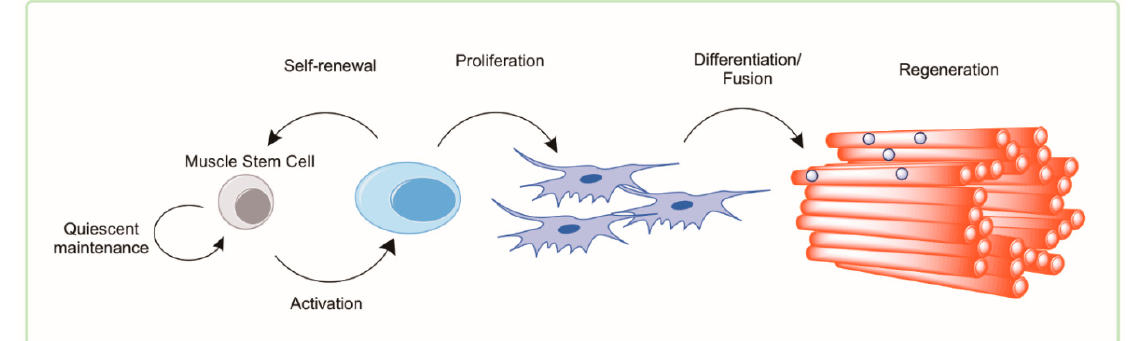
Figure 2. Activation of the Muscle Stem Cell. Adult, resident skeletal muscle stem cells—termed satellite cells—were originally identified in the hind limb muscle of frogs and rats by electron microscopy by 1961 [55]. These cells lie in a quiescent state; dormant with low metabolic flux and little cytoplasm (low energy demand/low energy storage). Following damage by mechanical or chemical stimuli, an activated satellite cell will hypertrophy to accommodate cytosolic machinery and organelle requirements for proliferation. This key functional step leaves the (recently quiescent and still relatively small) satellite cell with little in the way of energy stores or metabolic machinery (i.e., mitochondria) but an extremely high demand for energy substrates, metabolic intermediates, and amino acids. This state of high energy demand/low energy storage in accompanied by a simultaneous remodeling of the cell architecture. By using autophagy as a process to remove aged, unnecessary, or damaged components, the young/healthy activated satellite cell is capable of recycling those components into the building blocks needed to further proliferate. The proliferated satellite cells will asymmetrically divide allowing the self-renewal of the activated stem cell into the quiescent state; likewise requiring significant cytoplasmic reorganization and remodeling. The satellite cell progeny will undergo subsequent differentiation into mature myogenic cells that are able to fuse with the damaged myofibers accomplishing successful and complete regeneration.